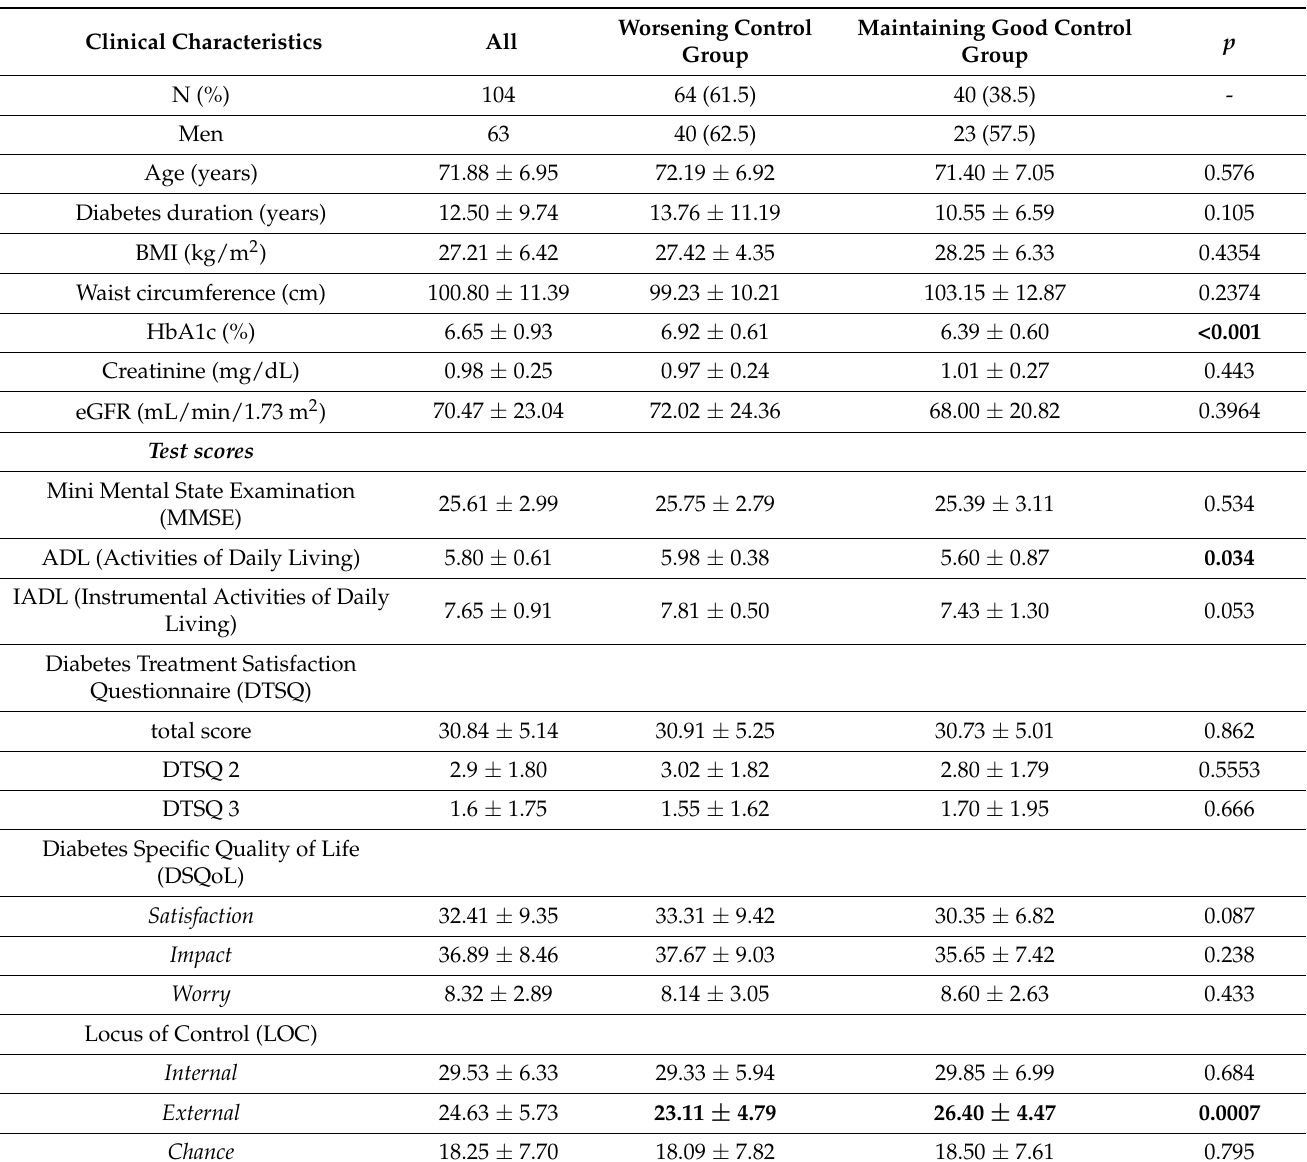
Table 4. Clinical characteristics and tests scores at baseline in T2D elderly subjects participating to in the study, in the <Worsening control> and <Maintaining good control>